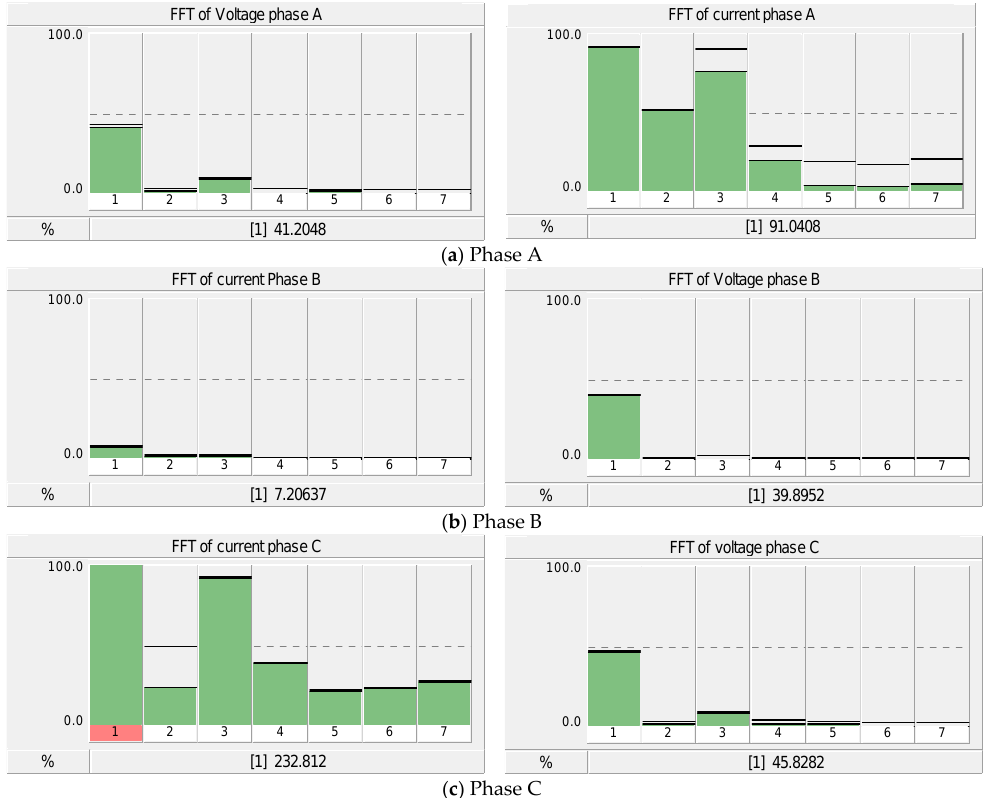
Figure 25. The voltage and current at the LV side (0.4 kV) transformer 500 kVA when the BRKC close circuit is at 0.7 s. The corresponding frequency spectrums of Figure 25 using FFT are shown in Figure 26.